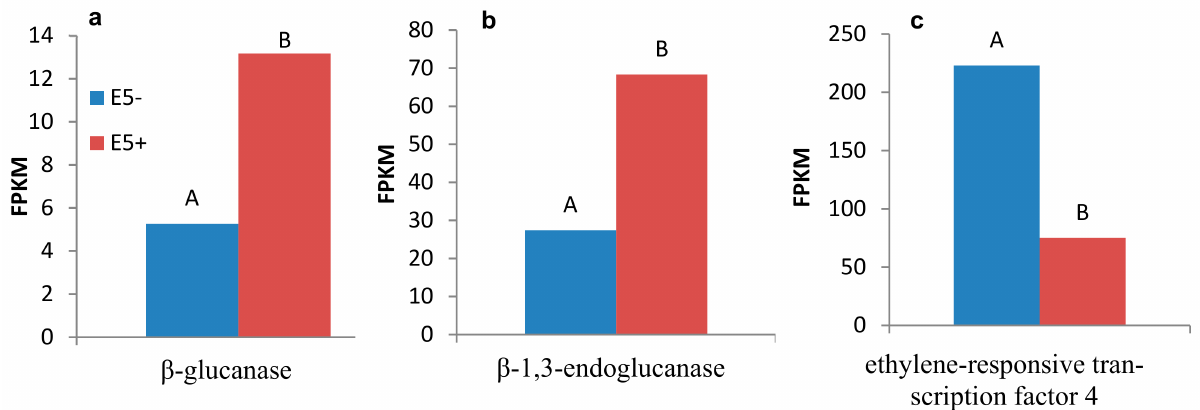
Figure 6. Expression levels (fragments per kilobase million) of the genes encoding β -glucanase ( a ), β -1,3-endoglucanase ( b ), and ethylene-responsive transcription factor 4 ( c ) in EMEK3 roots five d post-infestation with O. cumana (E5+) and in non-infested (E5 − ) roots. Different letters indicate significant difference between groups.